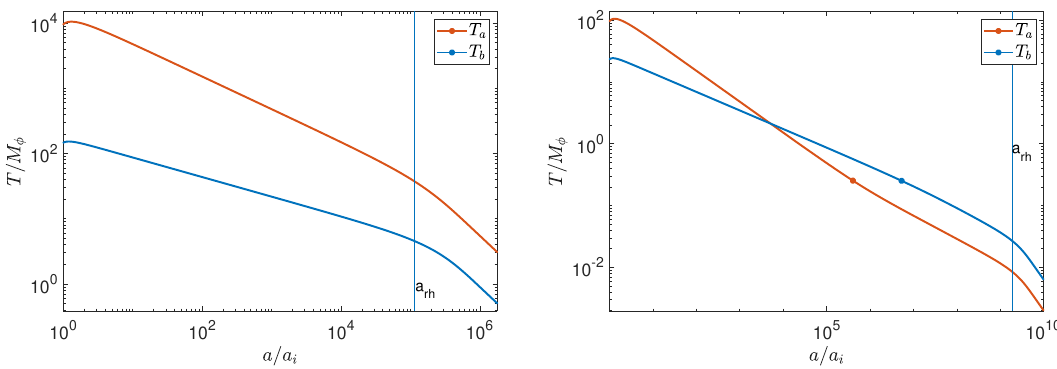
Figure 4. Left panel: temperature of the radiation baths as a function of scale factor in the case where the in(cid:13)aton decays to bosons in one sector (orange line) and fermions in the other (blue line). The in(cid:13)aton decay widths are (cid:0) 0 ;a = (cid:0) 0 ;b = 10 (cid:0) 9 M (cid:30) ; other constants are speci(cid:12)ed in eq. (3.3). Right panel: same as left panel, but with decay widths set at (cid:0) 0 ;a = 10 (cid:0) 16 and (cid:0) 0 ;b = 10 (cid:0) 14 M (cid:30) . The dots on the curves denote the point T = M (cid:30) = 4, below which the e(cid:11)ects from quantum statistics become